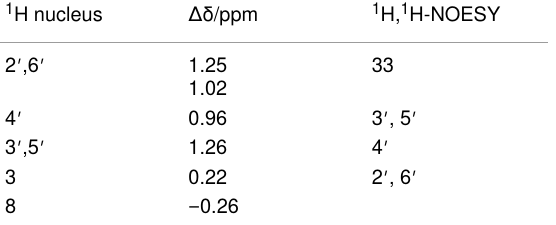
Table 1: Changes in the 1 H NMR chemical